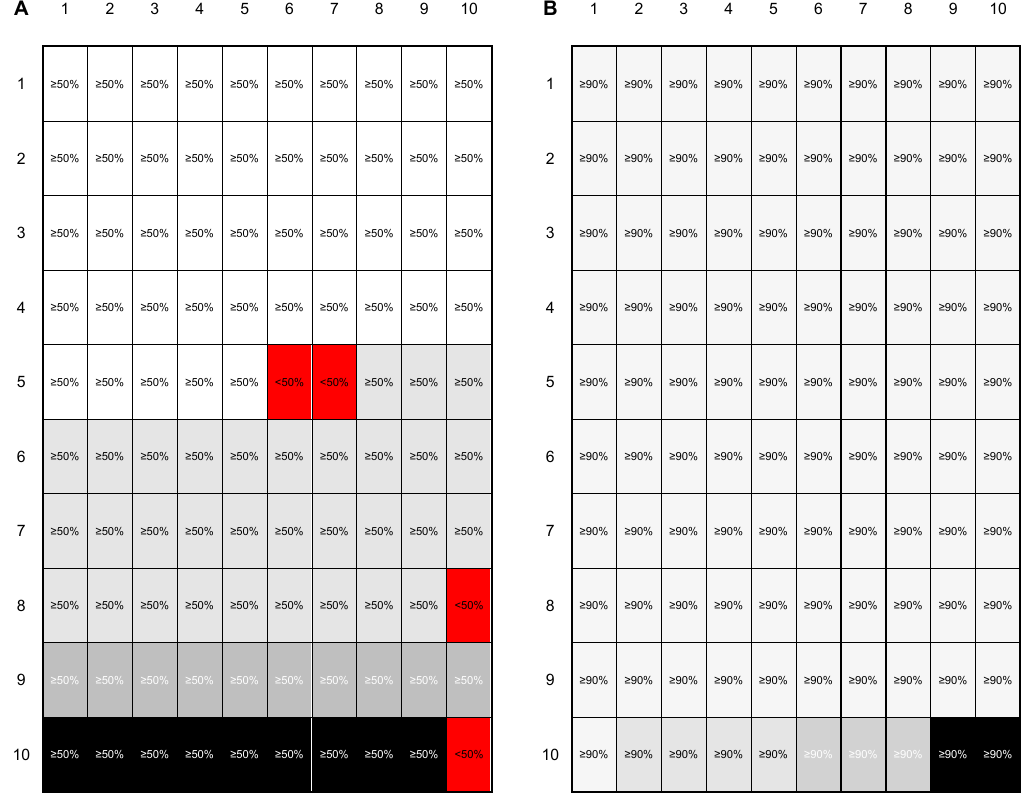
Table 3. Proportion of image patches with failed QC and classification accuracy according to image patch QC.